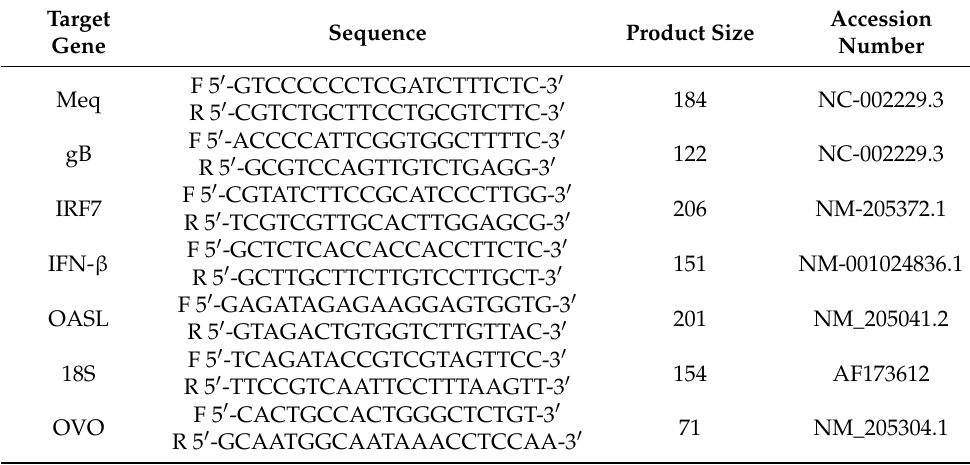
Table 1. Real-time PCR primer